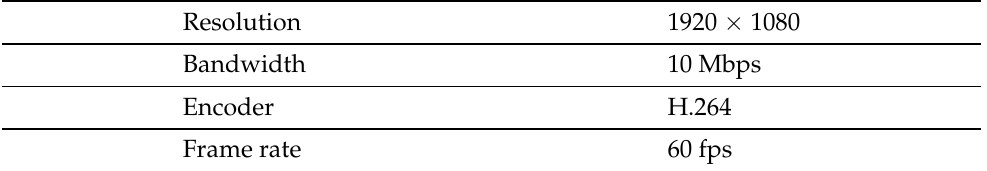
Figure 4. Cloud gaming test-bed. Table 2. Summary of Parsec streaming